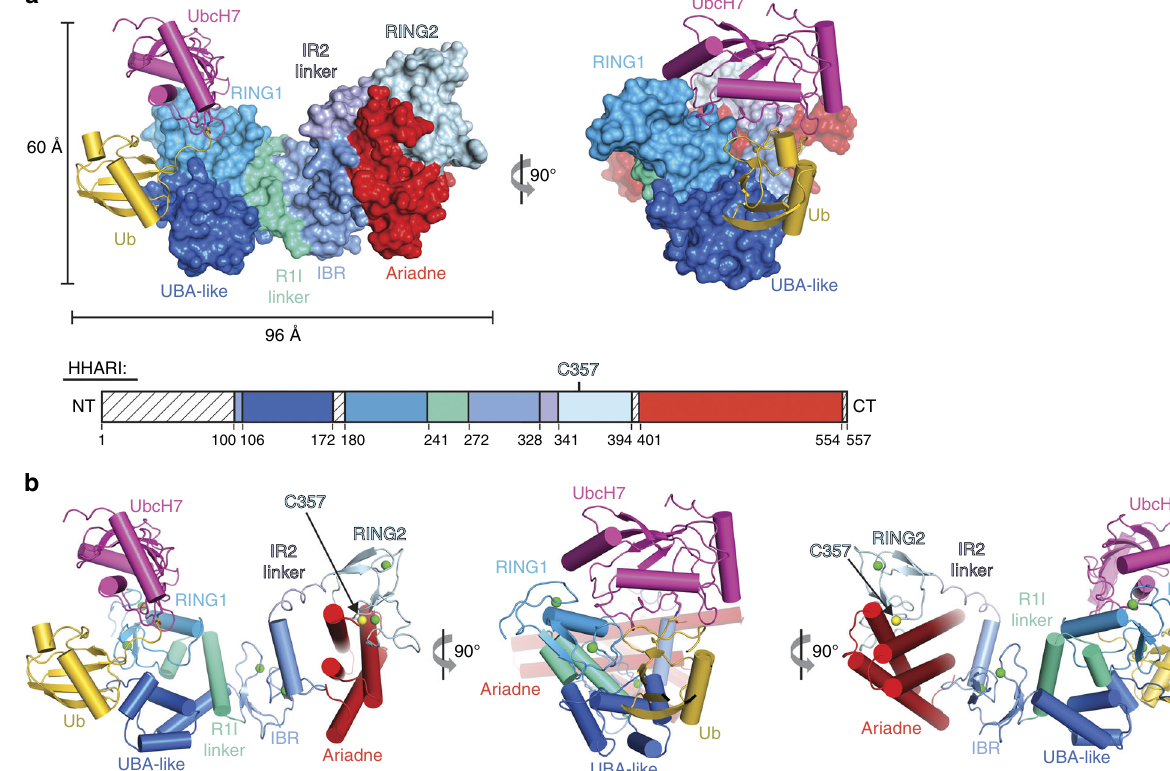
Fig. 1 Overall structure of HHARI in complex with UbcH7-Ub. a HHARI is shown as a surface representation with individual domains labeled and color coded. UbcH7 ( magenta ) and Ub ( gold ) are shown as cartoons and the isopeptide bond linking C86K of UbcH7 to Gly76 of Ub is shown as sticks . A schematic outlining the domain organization of HHARI is shown on the bottom with regions of disorder in the structure indicated by hatched boxes . b Cartoon representation of the HHARI/UbcH7-Ub complex colored as in a . The isopeptide bond linking C86K of UbcH7 to Gly76 of Ub is shown as sticks . Zinc ions coordinated by the RING1, IBR, and RING2 domains of HHARI are shown as green spheres and the sulfur atom of the HHARI catalytic cysteine (Cys357) is shown as a yellow